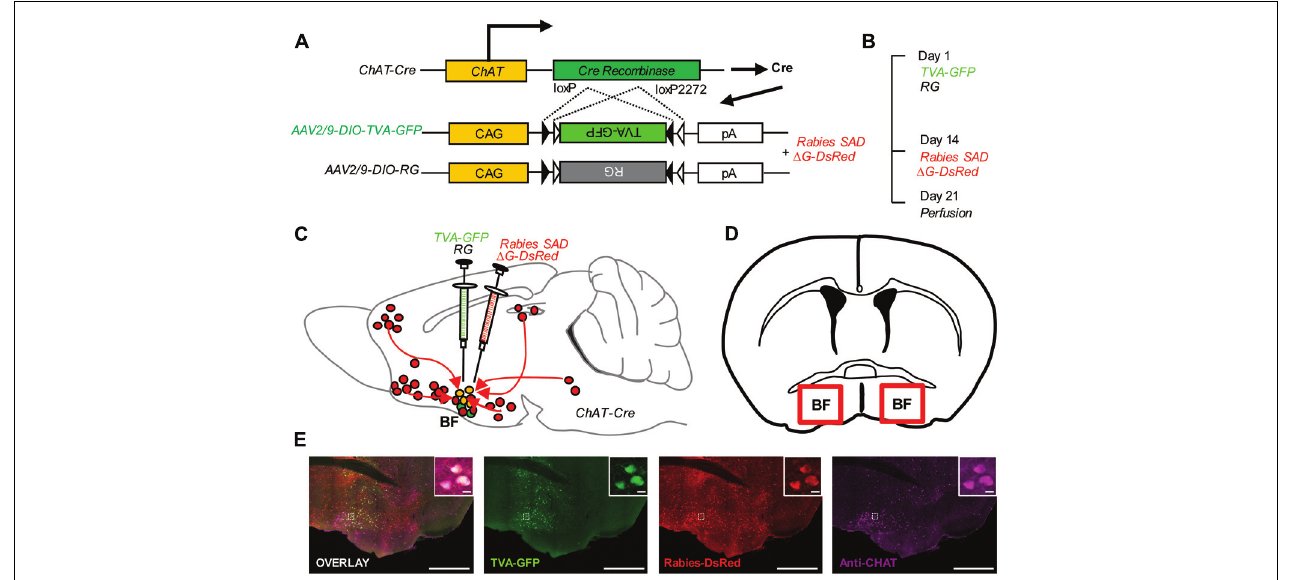
FIGURE 1 | Monosynaptic inputs to the BFCS using rabies-based transsynaptic tracing approach. (A) AAV helper viruses with Cre-dependent expression of TVA receptor and RG. Genetically modified rabies virus is pseudotyped with EnvA. The RG gene is replaced by DsRed. (B) Experimental timeline. (C,D) Sagittal section (C) and coronal section (D) for schematic illustration of AAV helper virus (green) and rabies virus (red) injection into the BF of ChAT-Cre mice. (E) Example of injection site: scale bar, 2 mm. Zoom-in view of injection site: scale bar, 10 µ m.